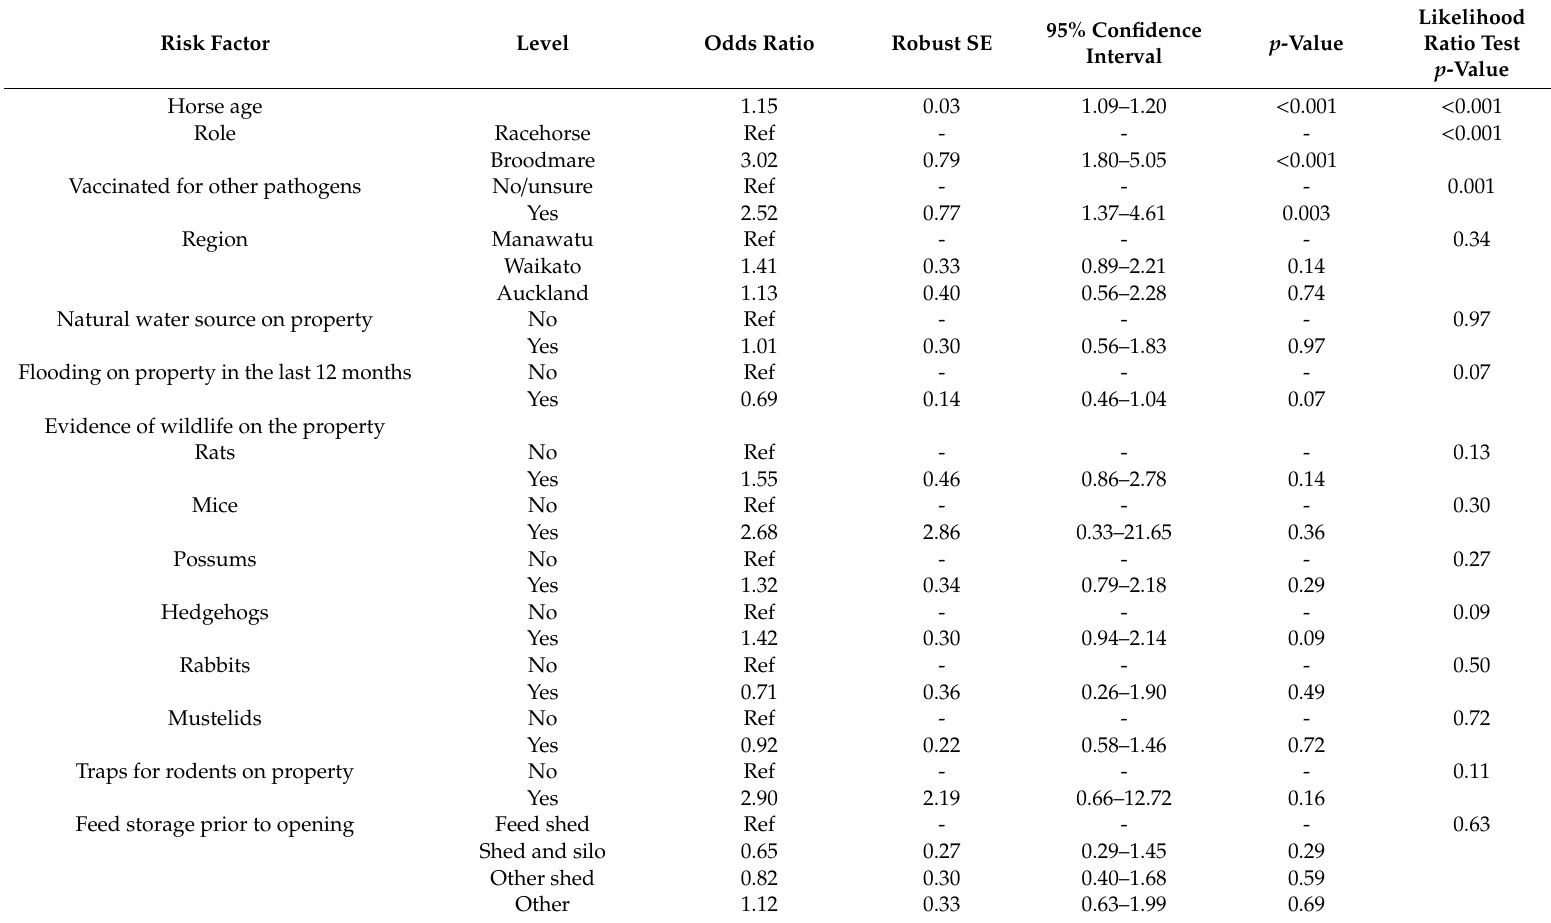
Table 2. Results of the univariable logistic regression investigating horse and property-level risk factors for positive microscopic agglutination tests (cut-o ff titre ≥ 50) to any of the Leptospira serovars tested in a convenience sample of racehorses and broodmares in New